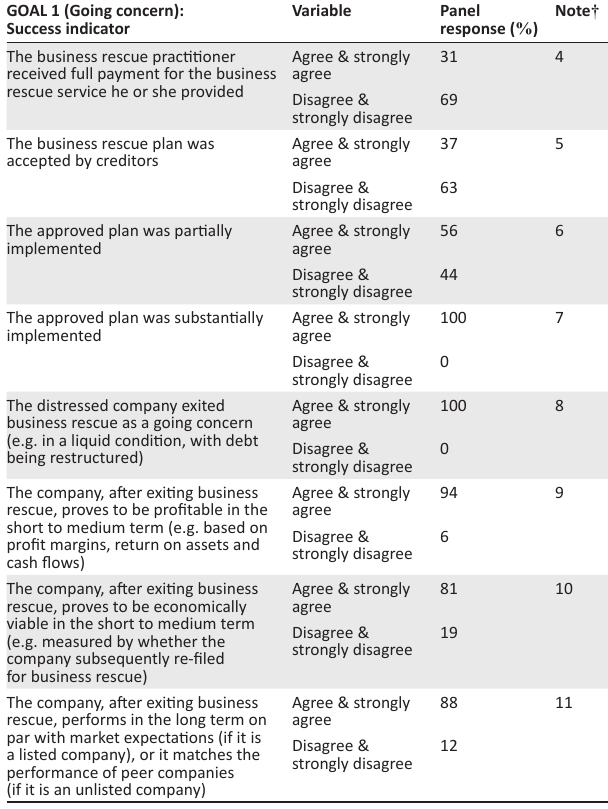
TABLE 4: Business rescue success indicators for Goal 1.